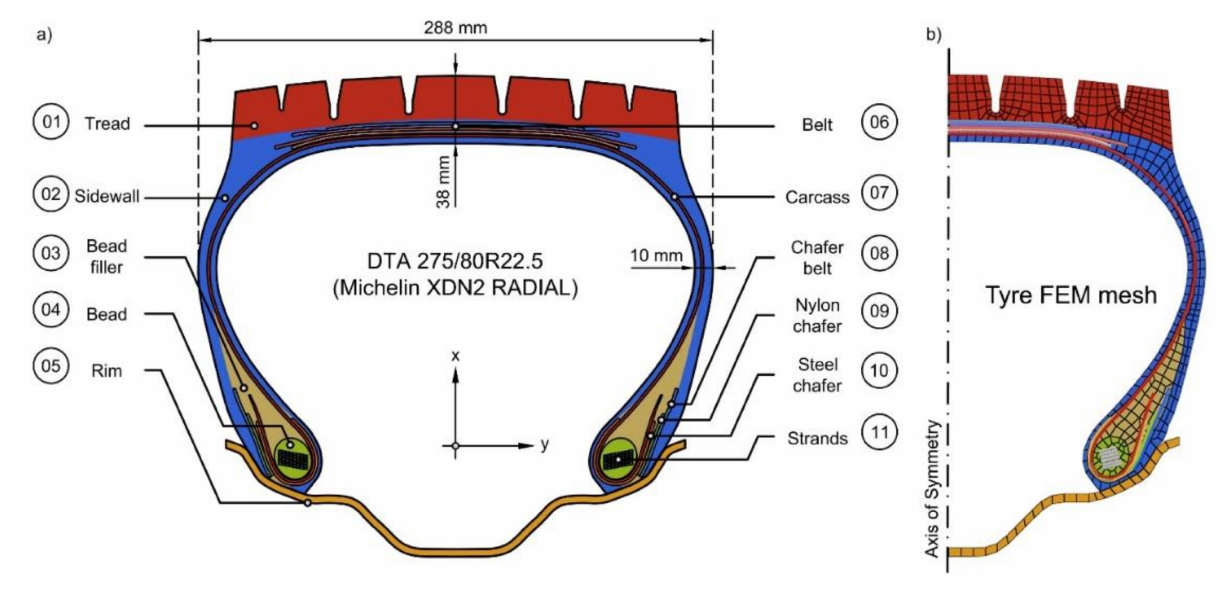
Figure 3. Cross-section view of radial tyre published by [5] ( a ); finite element mesh of the axial symmetric tyre model ( b